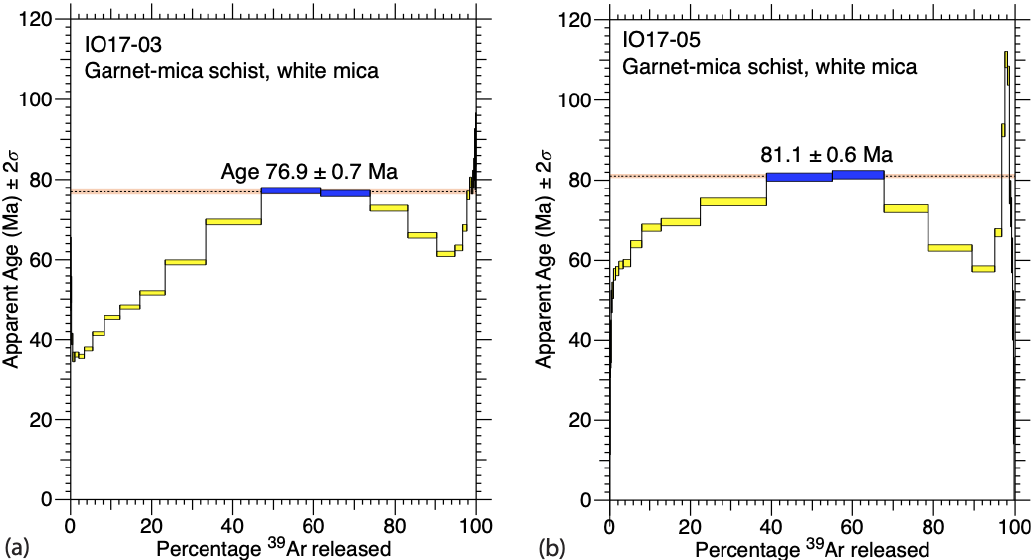
Figure 9. White mica age spectra from the structurally mid-level garnet–mica schist unit (IO17-03, IO17-05) produced in the Late Cretaceous ages, from mica grown during the Asteroussia